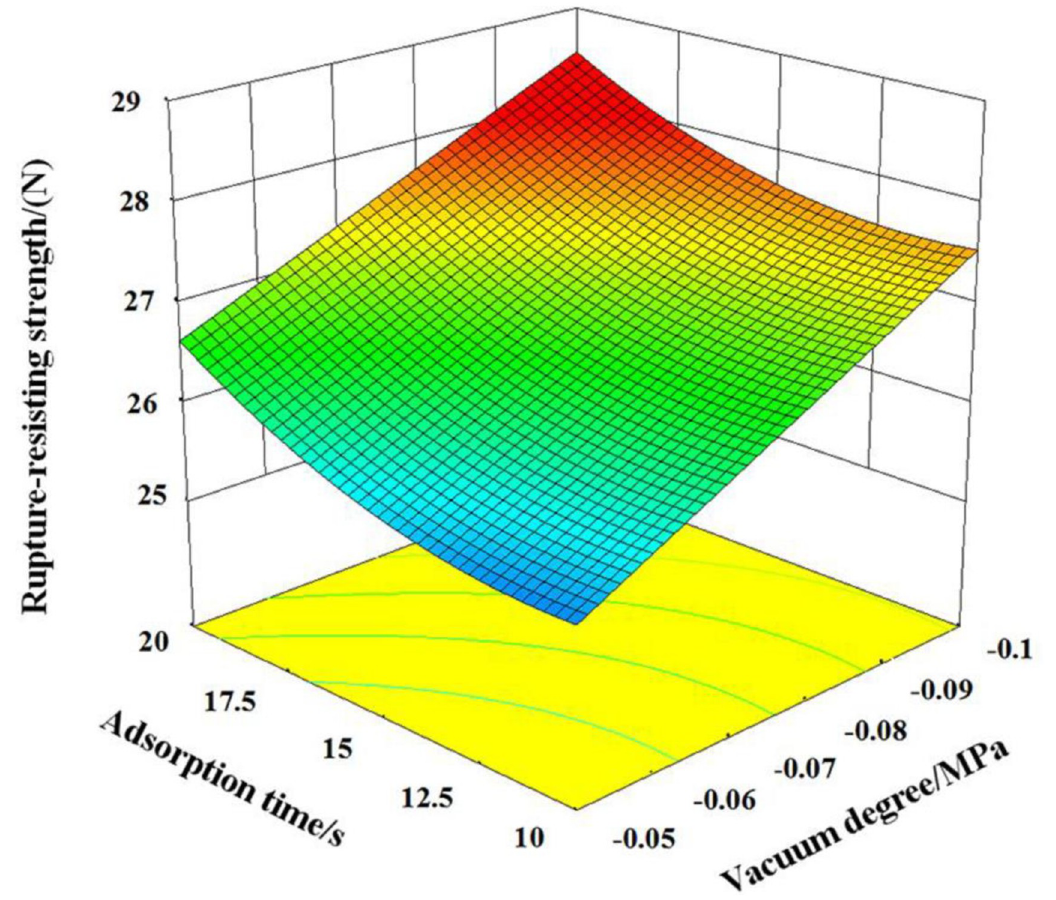
Fig 10. The interaction of the adsorption time and vacuum degree on the rupture-resisting